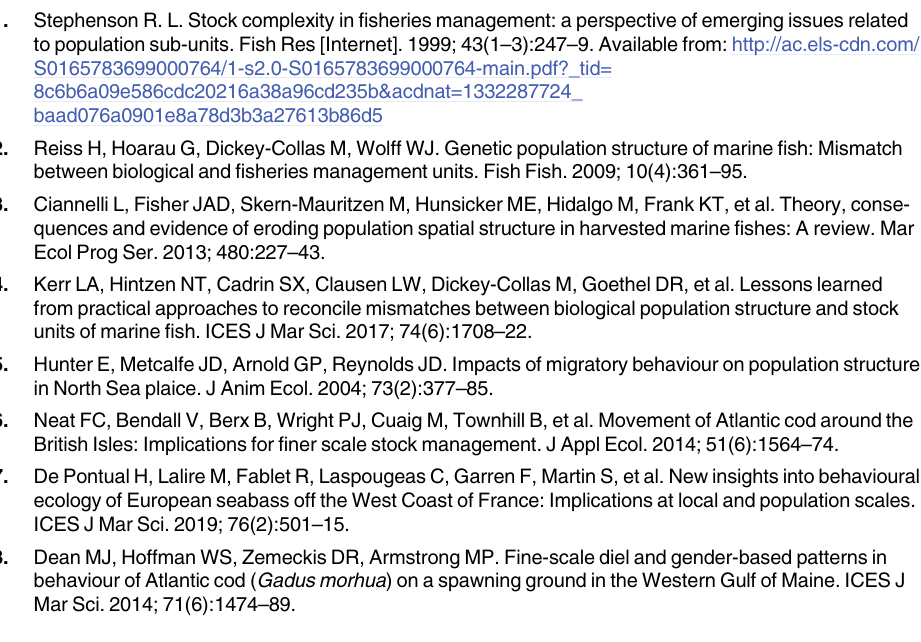
S8 Fig. Geographical movements of M . asterias . Movements of M . asterias tagged with elec- tronic tags (n = 6). Locations in space and time are coloured by month to illustrate seasonality. No measurements were taken during June. ICES Divisions are labelled where